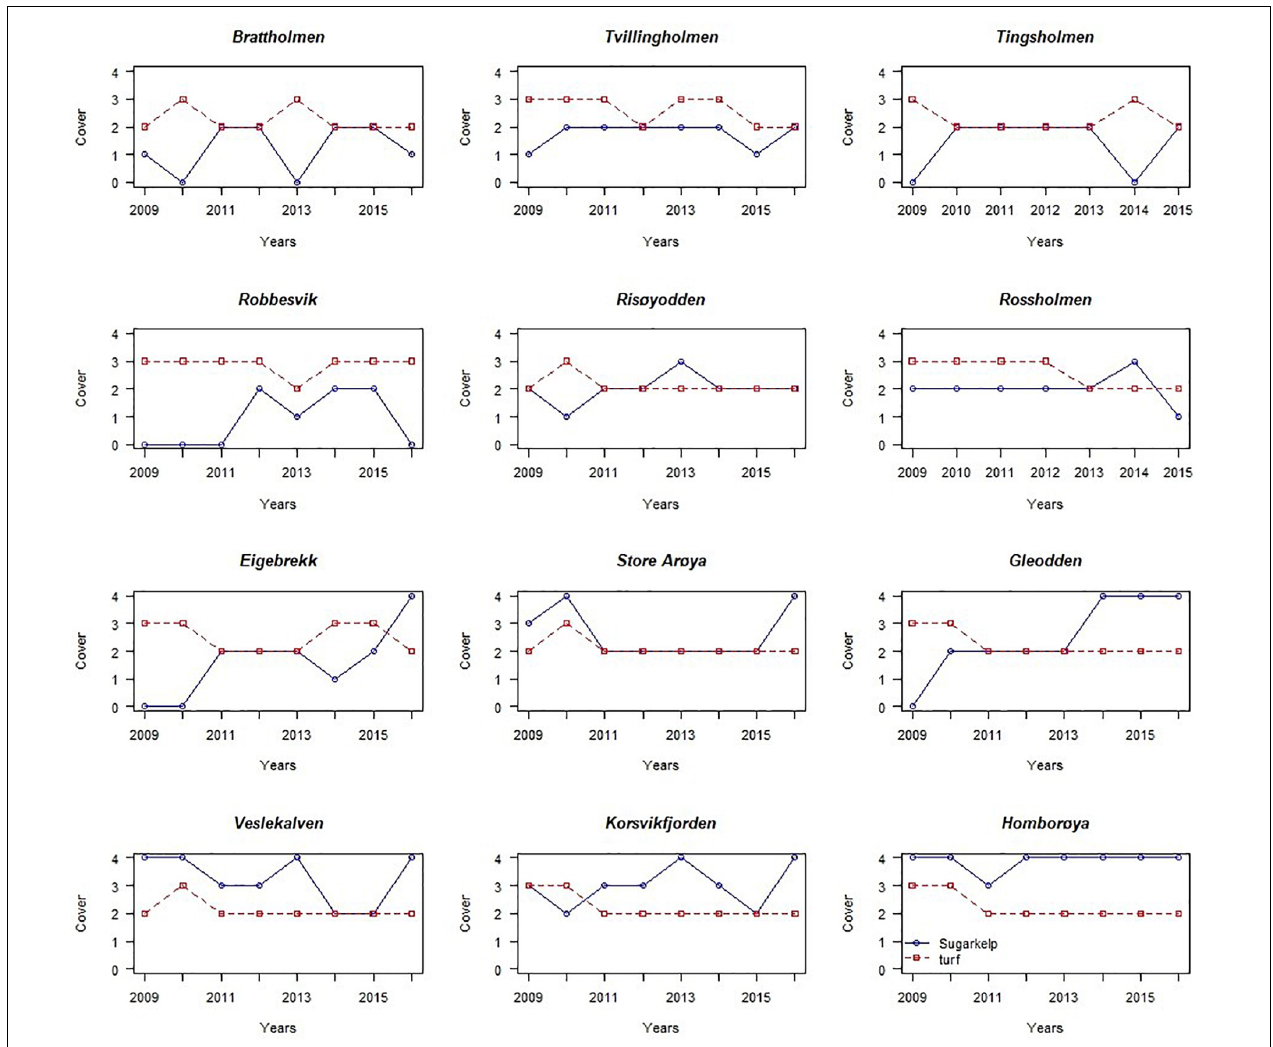
FIGURE 3 | The temporal pattern of abundance of sugar kelp ( S. latissima , blue line) and turf algae (red line) at 12 monitoring stations in Skagerrak and the North Sea, in the period 2009–2016, shown as changes in cover, semi-quantitatively measured (details in the